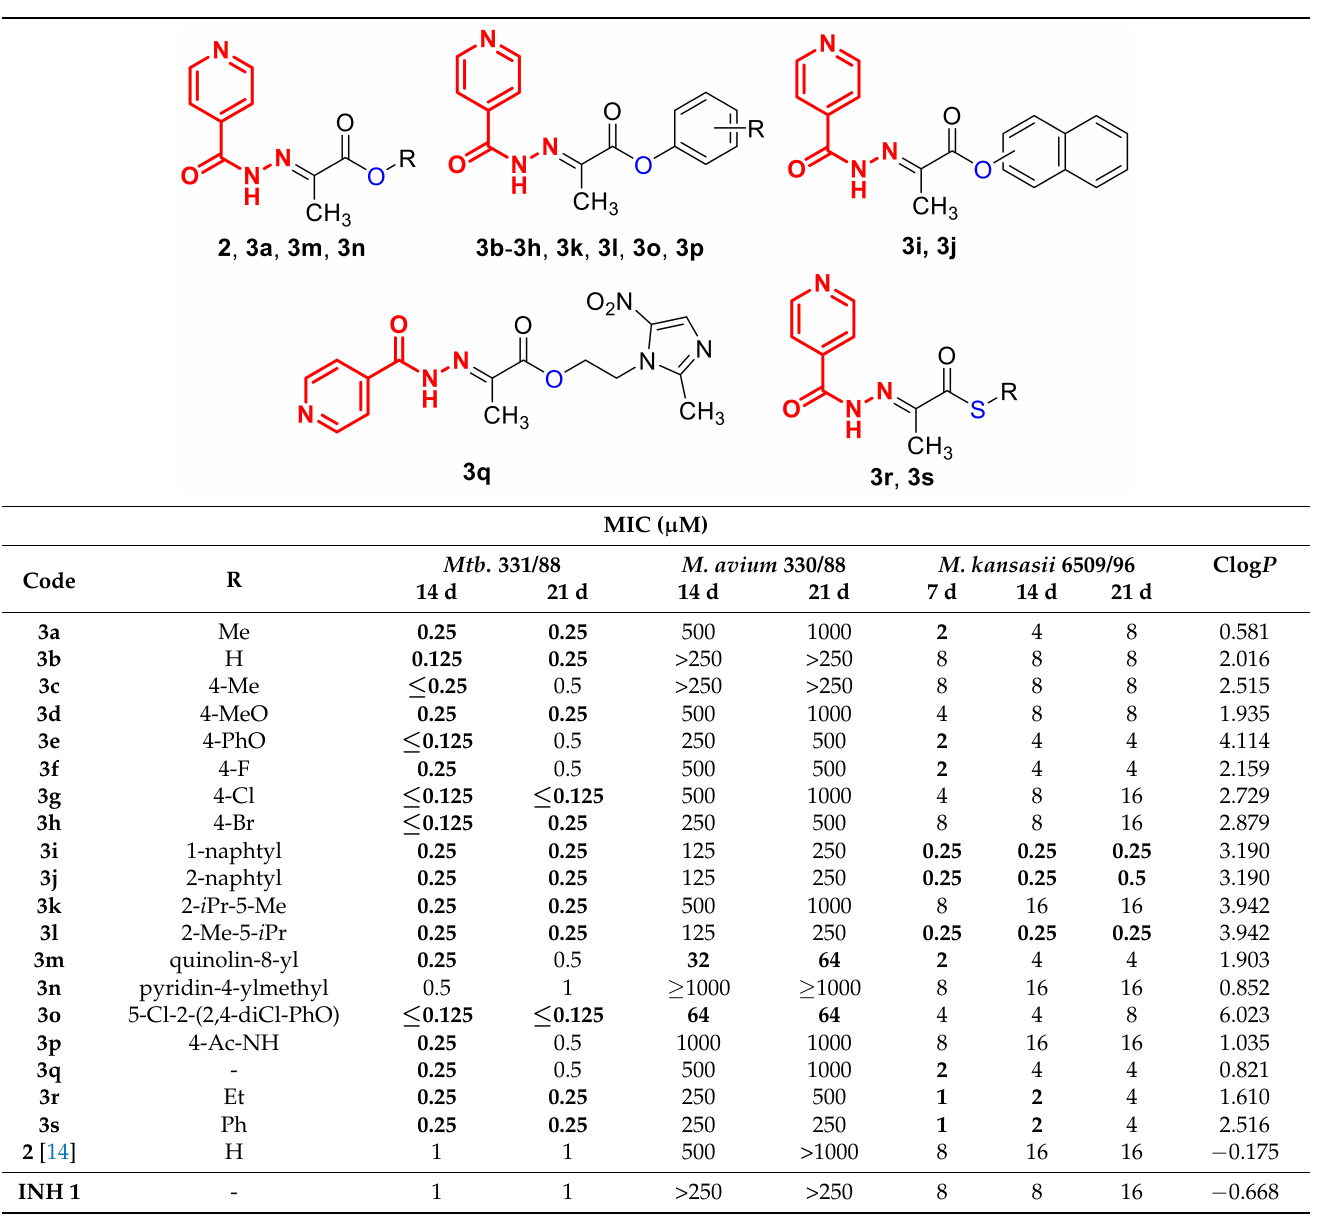
Table 1. Structure and antimycobacterial activity of esters 3